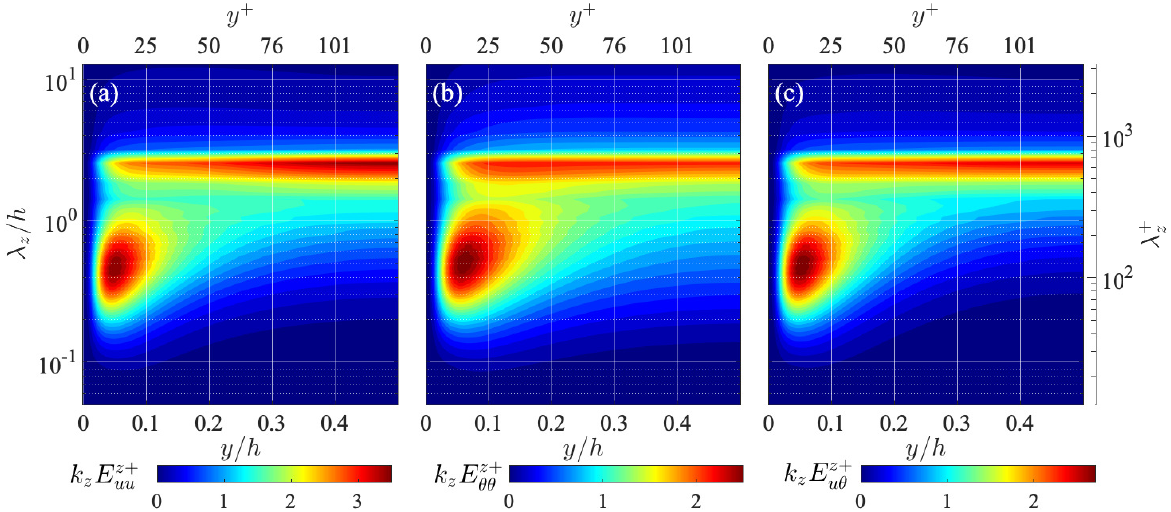
Figure 3. Space-wavelength ( y − λ z ) diagrams of spanwise one-dimensional premultiplied spectra of ( a ) streamwise turbulent energy k z E z uu , ( b ) temperature fluctuation k z E z correlation k z E z . The values are scaled by u 2 τ , T 2 τ , and u τ T τ , u θ